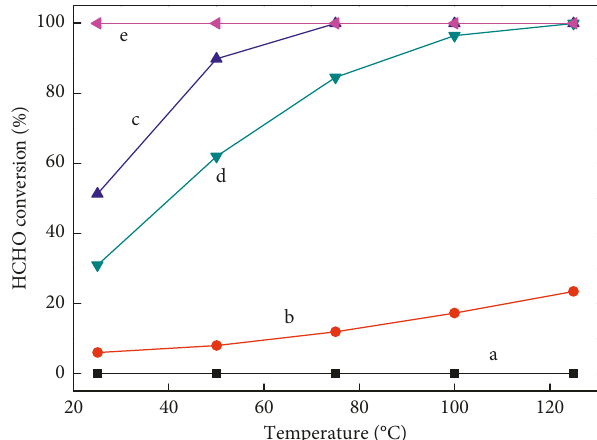
Figure 1: Catalytic activities of the as-prepared catalysts: (a) MORn; (b) 1% Pt/MORn; (c) 1% Pt/MORn-H; (d) 1% Pt/MORn- OH; (e) 1%